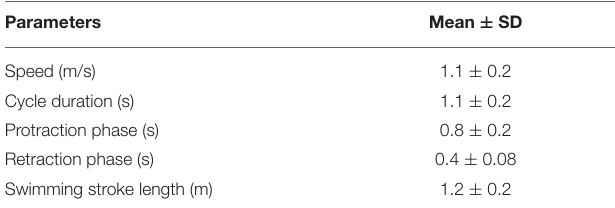
TABLE 1 | Forelimb stride cycle parameters in horses during untethered swimming (n =